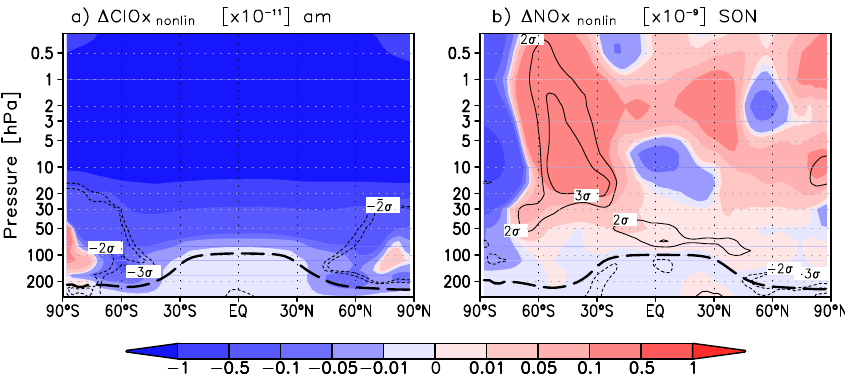
Figure 4. Latitude-height section of the nonlinear change of the annual mean ClO x mixing ratio (a) and the September to November mean NO x mixing ratio (b) between 1960 and 2000. The contour lines indicate the regions where the changes are larger than ± 2 σ and ± 3 σ . The bold dashed line shows the mean tropopause location of the R1960 simulation for the annual mean and the SON mean